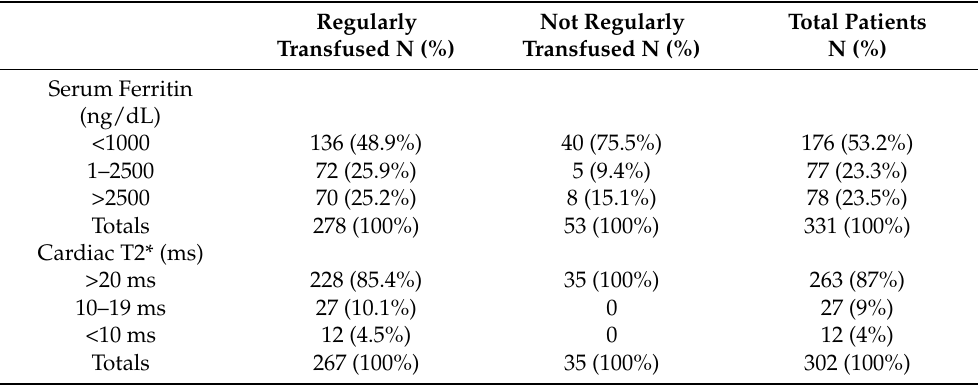
Table 3. Iron-load status in patients with thalassaemia in Cyprus; serum ferritin, cardiac iron load, and liver iron concentration (LIC) according to transfusion